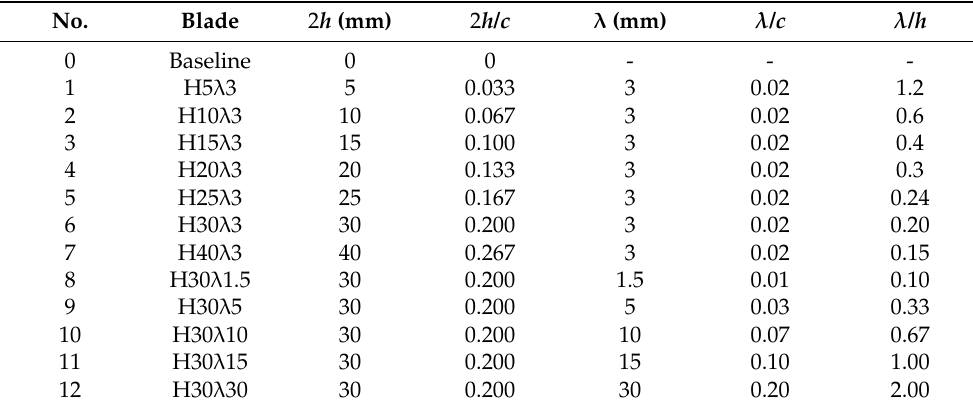
Figure 11. The serrated trailing-edge (TE) blade and parameter definitions. Table 1. Design parameters of the serrated TE